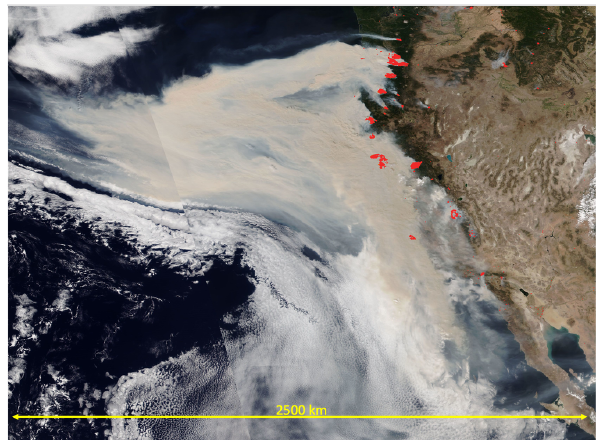
Figure 5. Smoke plume and clouds at the US west coast on 9 September 2020 as seen by NOAA-20 Visible Infrared Imaging Radiometer